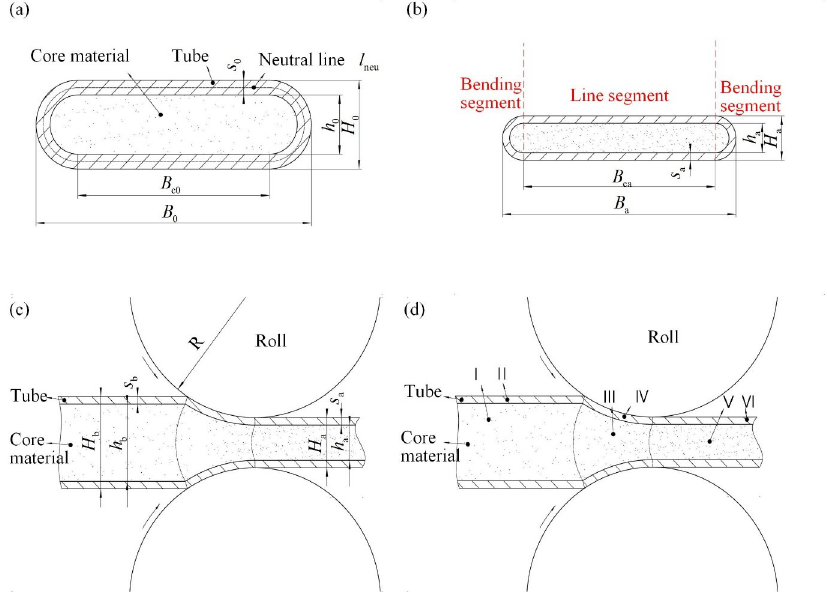
Fig 2. Section of the flat rolling process. (a) Cross section of preformed billet, (b) cross section at the outlet side, (c) vertical section, and (d) division of the deformation zone.